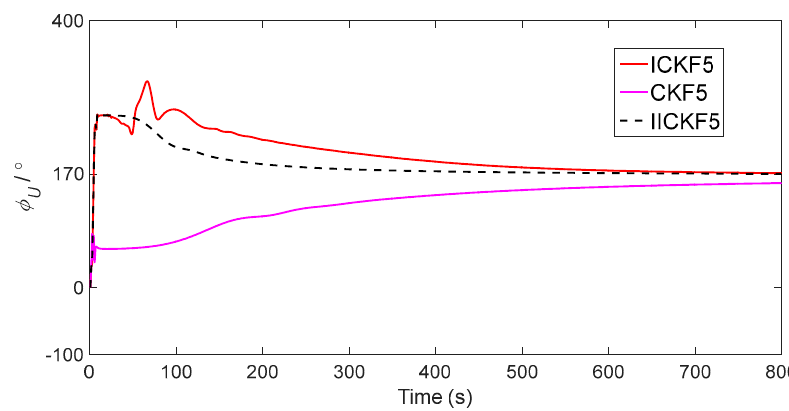
Figure 5. The estimated azimuth misalignment angles of CKF5, ICKF5 and IICKF5.